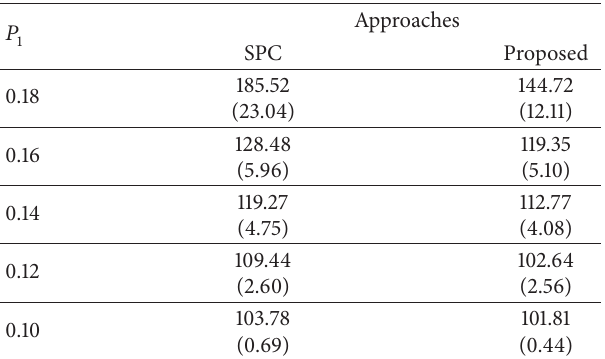
Table 3: Performance comparisons among three approaches in the case of an unknown process with the misuse of